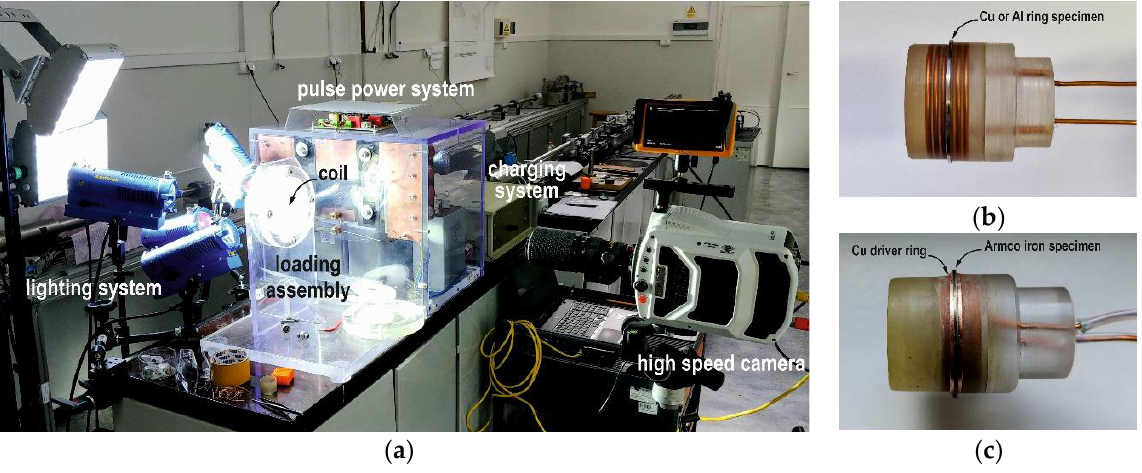
Figure 2. Electromagnetic ring expansion setup ( a ); solenoid coil used to direct expansion of the ring specimens made of OFE copper or aluminum ( b ); solenoid coil with the copper driver ring used for an indirect expansion of the Armco iron ring specimens ( c ).